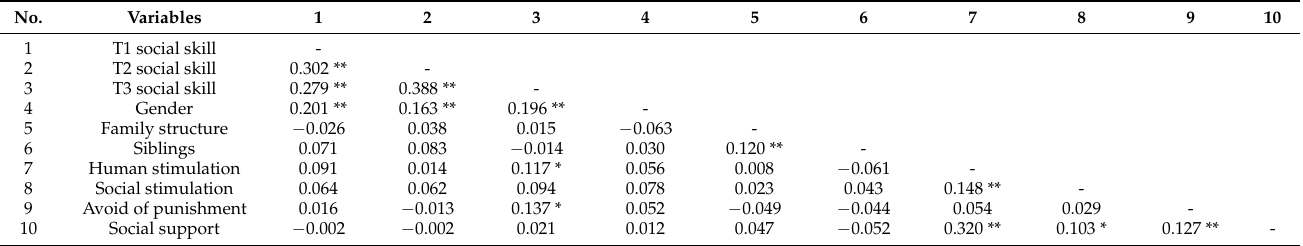
Table 2. Bivariate Correlations among Main Study